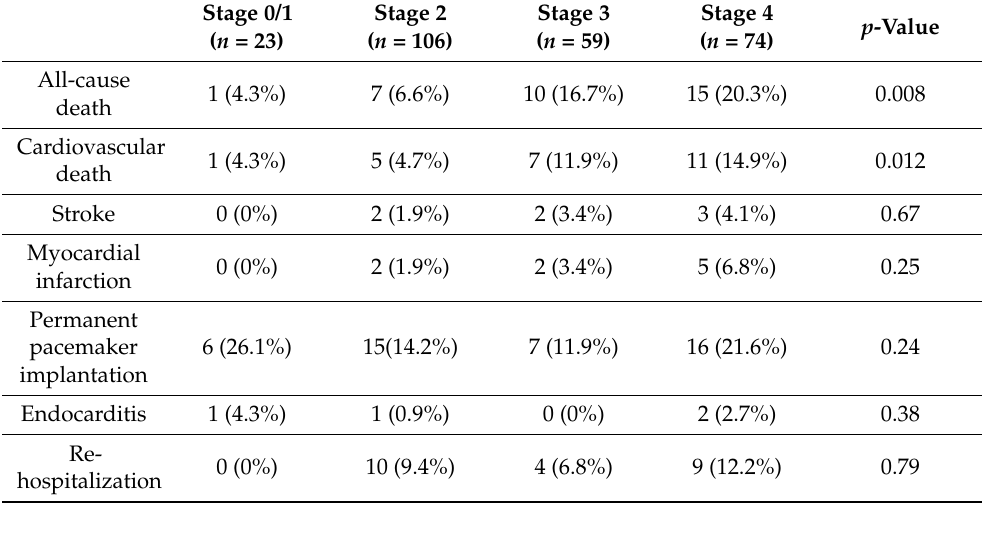
Table 3. Clinical outcomes at 1-year after TAVI stratified by stage of cardiac damage.